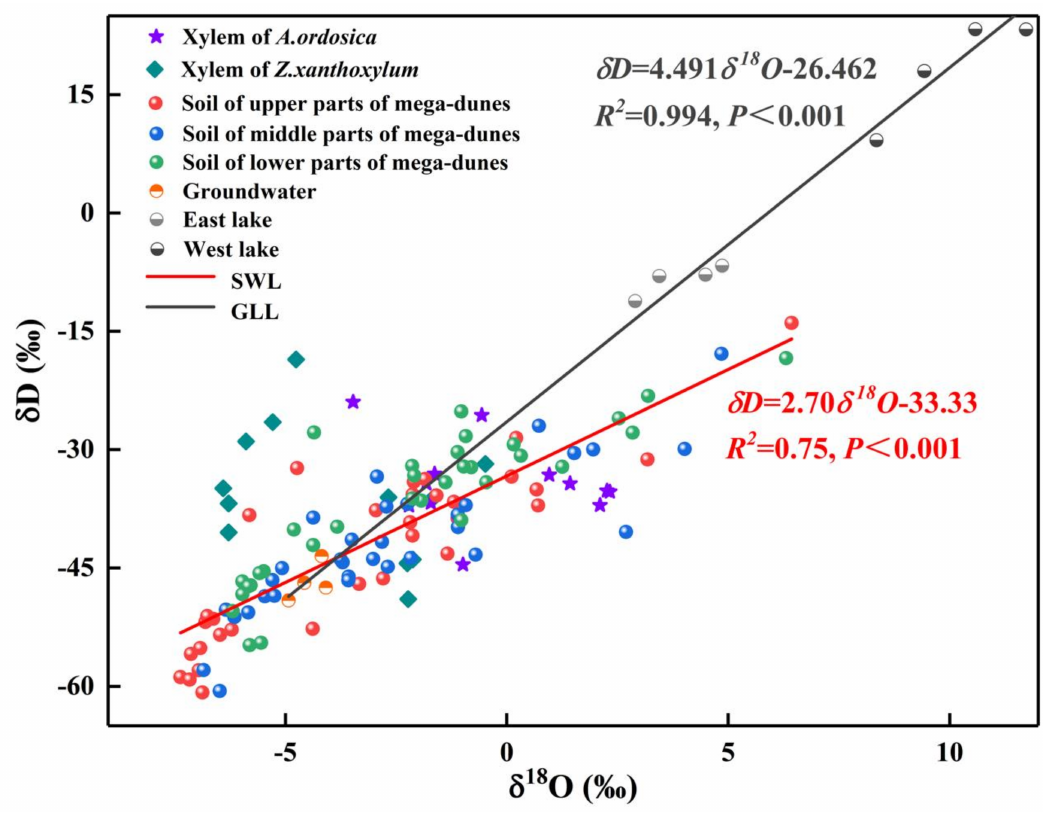
Figure 6. The δ D- δ 18 O plots of xylem water and potential water sources for Z. xanthoxylum and A. ordosica , including soil water from different soil layers, groundwater, and lake water during the sampling period. SWL is the soil water evaporation line which is fitted based on the isotopic values of soil water. GLL is fitted based on the isotopic values of groundwater, east lake water, and west lake